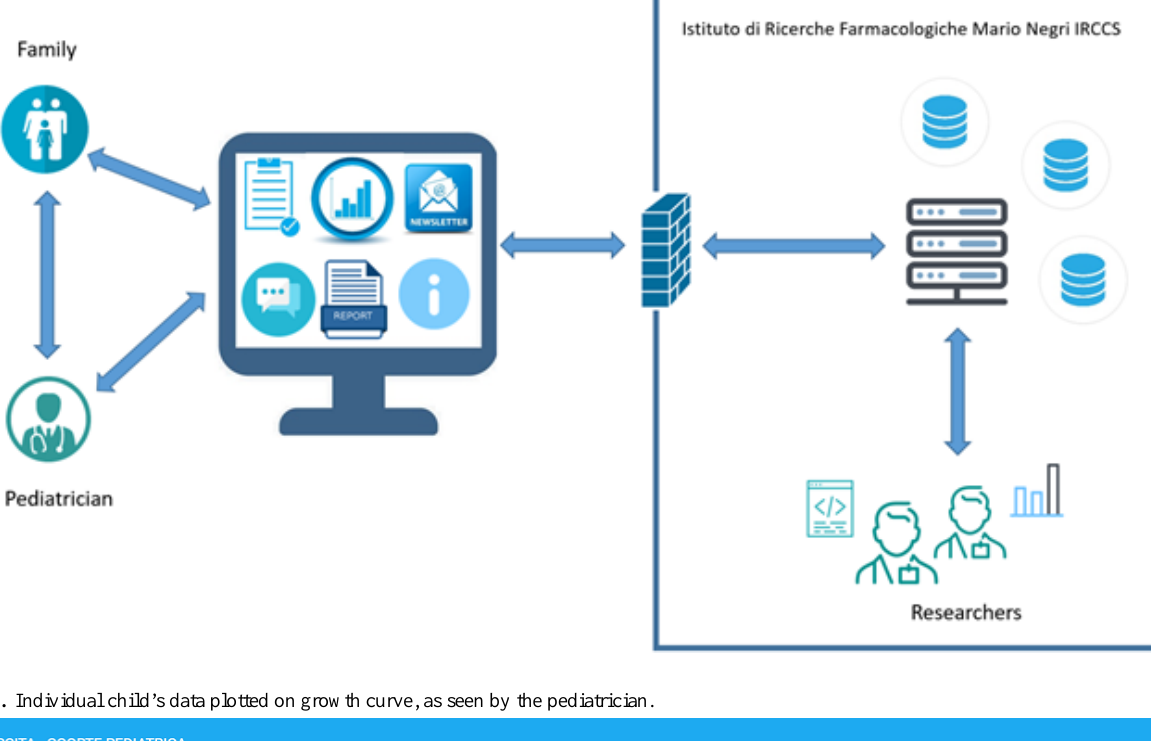
Figure 2. Functions of the platform and its architecture.